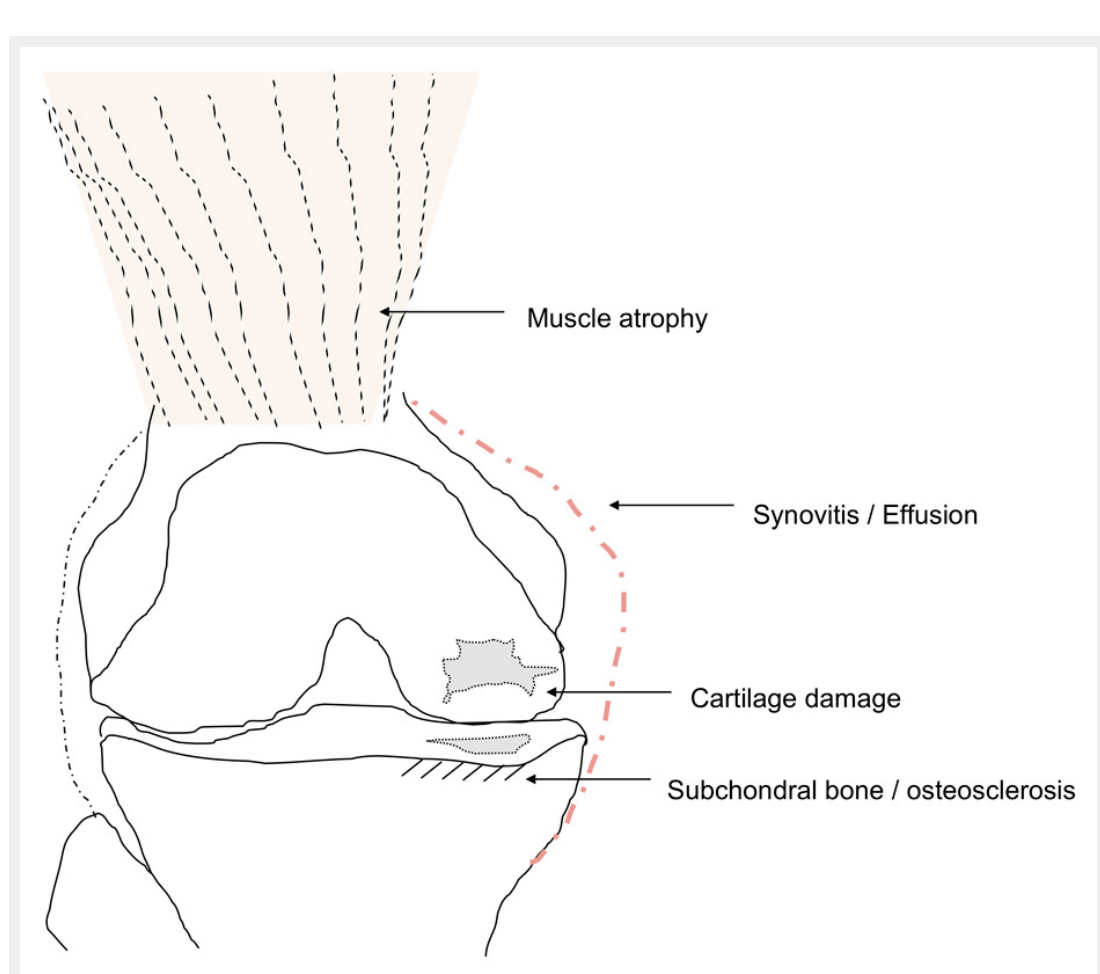
Figure 1 Schematic illustration of OA as a “whole joint disease” with structures involved in OA pathology. Muscle atrophy can cause OA, but is also seen as a consequence of OA, e.g., pain-induced. Synovitis with secretion of proinflammatory cytokines into the joint space correlates with pain and radiological progression. Cartilage degradation is the hallmark of OA. Subchondral bone pathology is also observed in OA, ultimately leading to